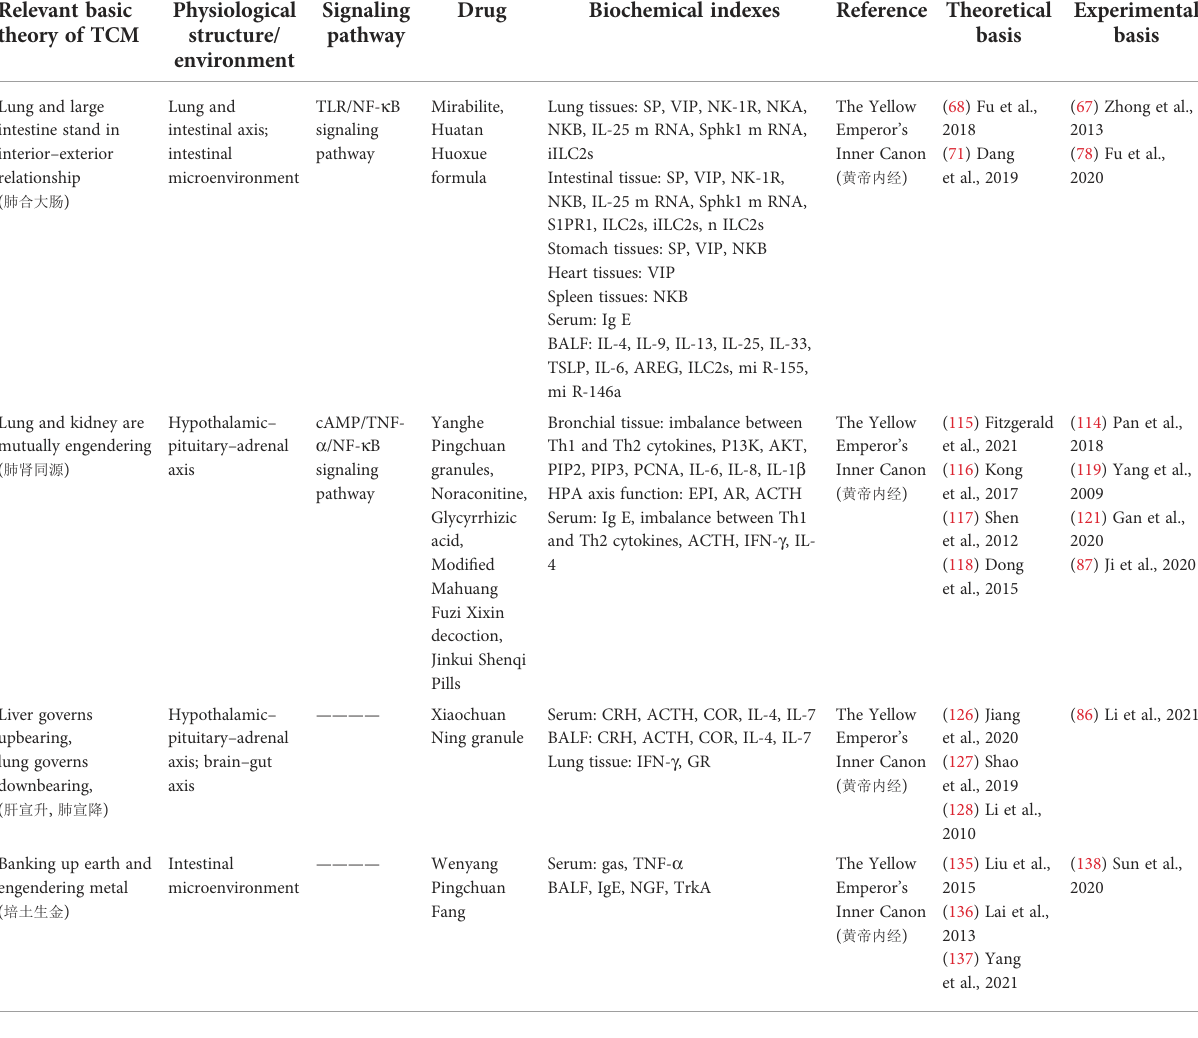
TABLE 1 Corresponding therapeutic drugs and biochemical indexes of asthma from the perspective of cellular endocrine and basic theory of traditional Chinese medicine (TCM). Relevant basic